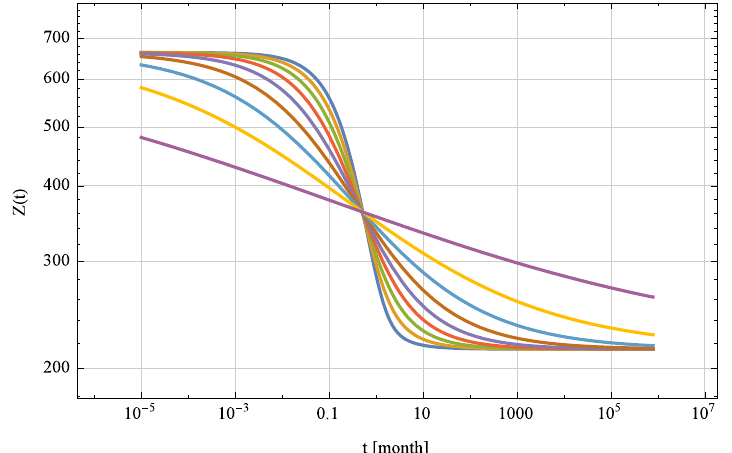
Figure 14. Time dependent impedance Z ( t ) derived from the inverse Laplace transform of the ultracapacitor with different fractal exponents q 2 f i= 10 g 9 corresponds to q = 1 = 10